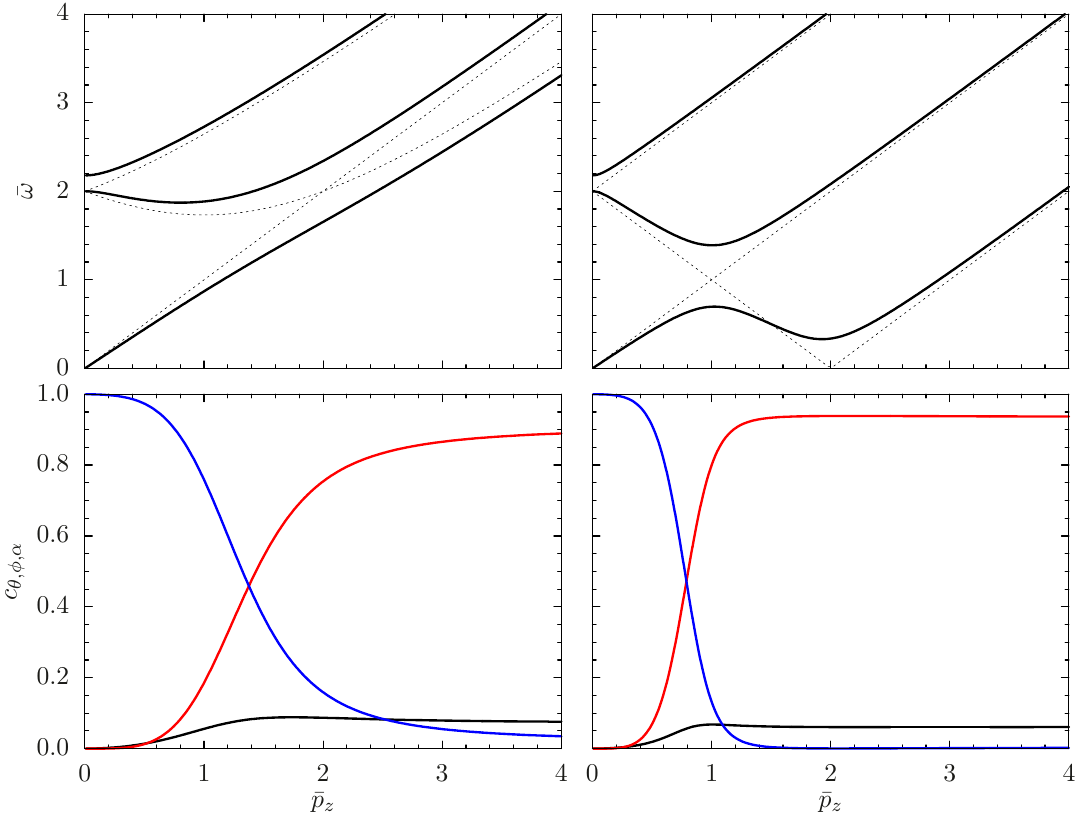
Figure 4 . Dispersion relations of the three light modes and the composition of the lightest mode for x = 2 and (cid:22) H = 0 : 5 (left panels) or (cid:22) H = 1 (right panels). Upper panels: the dispersion relations obtained from the inverse propagator (4.13) are indicated by the thick solid lines, whereas the dashed lines show for comparison the results in the chiral limit, given by eqs. (3.8) and (3.9). Lower panels: values of the coe(cid:14)cients c (cid:18);(cid:30);(cid:11) , obtained from the spectral representation (4.17); c (cid:18) is shown in black, c (cid:30) in red and c (cid:11) in